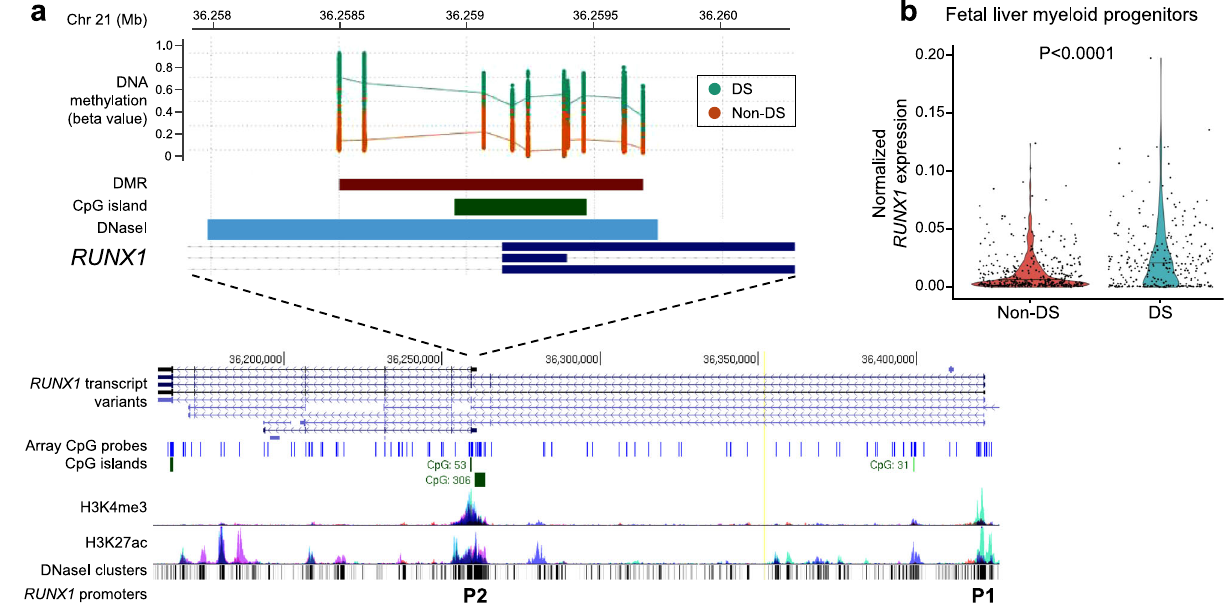
Fig. 4 Down syndrome (DS)-associated differentially methylated region (DMR) overlapping RUNX1 regulatory region. a DS-associated DMR ( Š idák- corrected P value = 2.30 × 10 − 84 from comb-p), which included 11 CpGs, had the greatest mean Δ β -value ( + 0.273) between DS (teal, N = 196) and non- DS (red, N = 439) newborns, and overlapped a large regulatory region that encompasses the RUNX1 proximal P2 promoter and the fi rst exon of the P2 isoform, or exon 4 of the P1 isoform. The position of the DMR (brown horizontal bar) is shown relative to the RUNX1 gene in the UCSC Genome Browser (https://genome.ucsc.edu/), along with tracks for chromatin accessibility (DNase I clusters, darkness corresponds to signal strength) and histone modi fi cations (H3K4me3, H3K27ac), CpG islands (green), and a custom track displaying positions of the array CpG probes (blue). High coverage of CpG probes is shown both at the proximal P2 and distal P1 promoters of RUNX1 . b Violin plot showing normalized RUNX1 expression derived from single-cell qRT-PCR on index-sorted FL myeloid progenitors with megakaryocyte – erythroid potential (Lin − CD34 + CD38 + CD45RA − ) from non-DS ( N = 3) and DS ( N = 3) subjects. RUNX1 expression was signi fi cantly increased in DS myeloid progenitor cells ( N = 292) compared with non-DS cells ( N = 412) ( P = 3.81 × 10 − 5 , two-sided Wilcoxon rank-sum test). Horizontal lines represent the median.